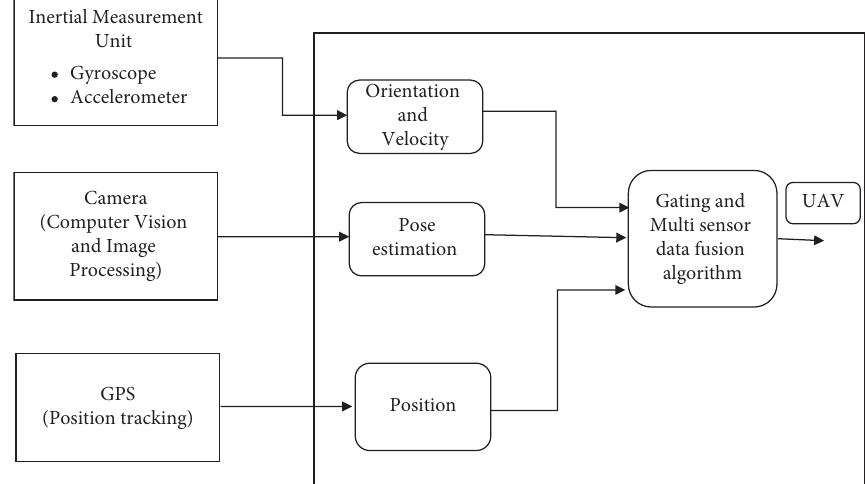
Figure 2: Multisensor data fusion architecture pipeline.